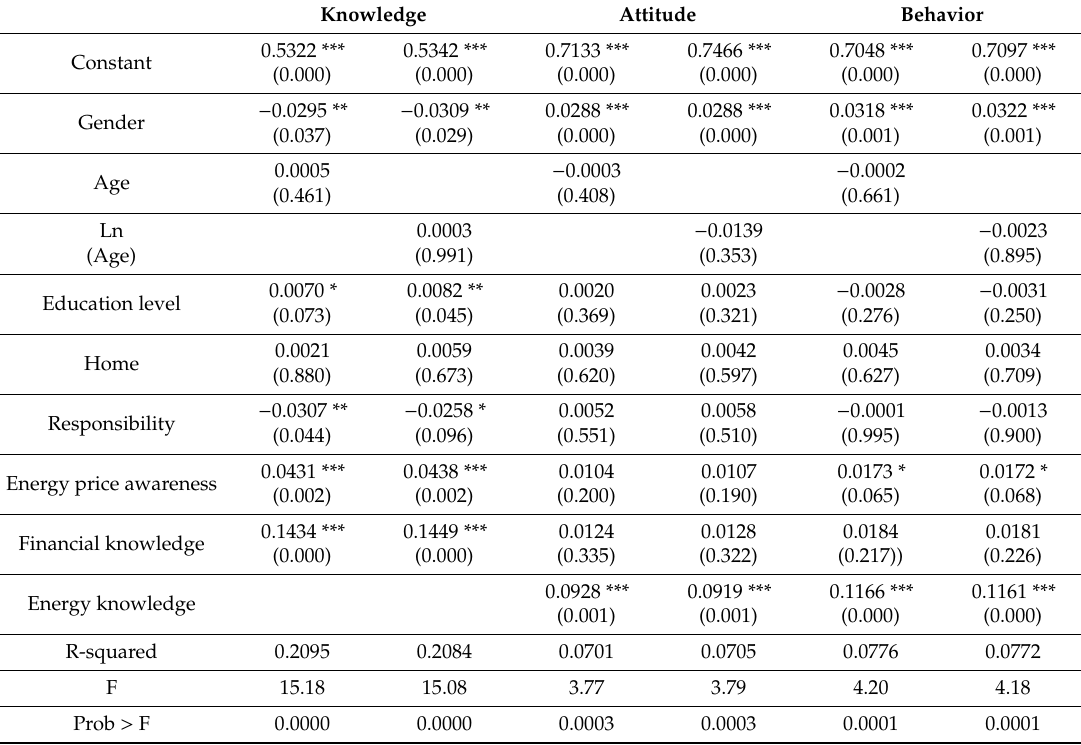
Table 2. Ordinary least squares (OLS) estimations result for energy literacy dimensions: knowledge, attitude and